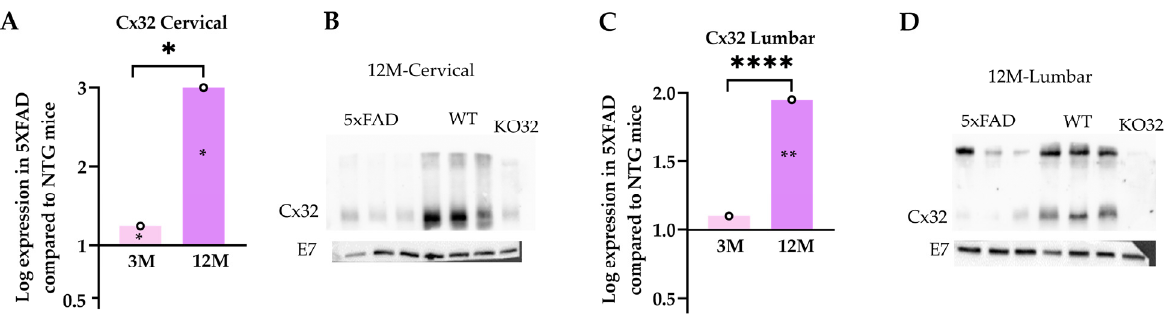
Figure 11. Cx32 mRNA and protein levels in the spinal cord of 5xFAD mice. Cx32 mRNA levels increased significantly in the cervical ( A ) and lumbar ( C ) spinal cord tissues at both ages of 5xFAD mice. The asterisks inside the columns of mRNA graphs indicate p -values representing significance of connexin levels in 5xFAD compared with WT controls, while the asterisks outside the columns show the significance between different age groups of 5xFAD mice. ( B , D ) However, immunoblot analysis revealed reduced Cx32 protein levels in 12M 5xFAD mice compared with the WT samples at both spinal cord levels. β -Tubulin was used as an internal control for the mRNA analysis and as a loading control (E7) for the immunoblot analysis. The statistical analysis for the mRNA was performed by unpaired t -test ( n = 6 for all genotype and age groups). Data are presented as mean ± SD. Significance is given as: * p < 0.05, ** p < 0.01, **** p < 0.0001.